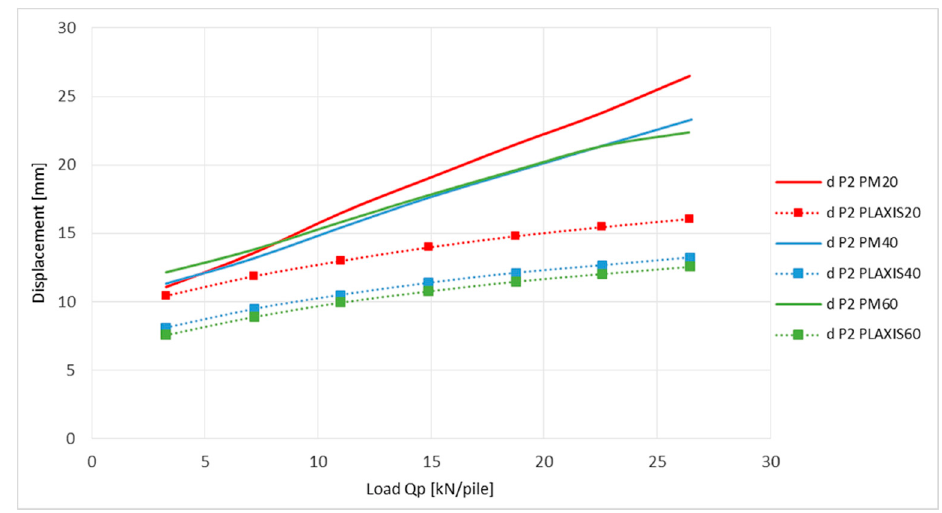
Figure 16. Comparison of vertical deflection of geogrid at place P2.